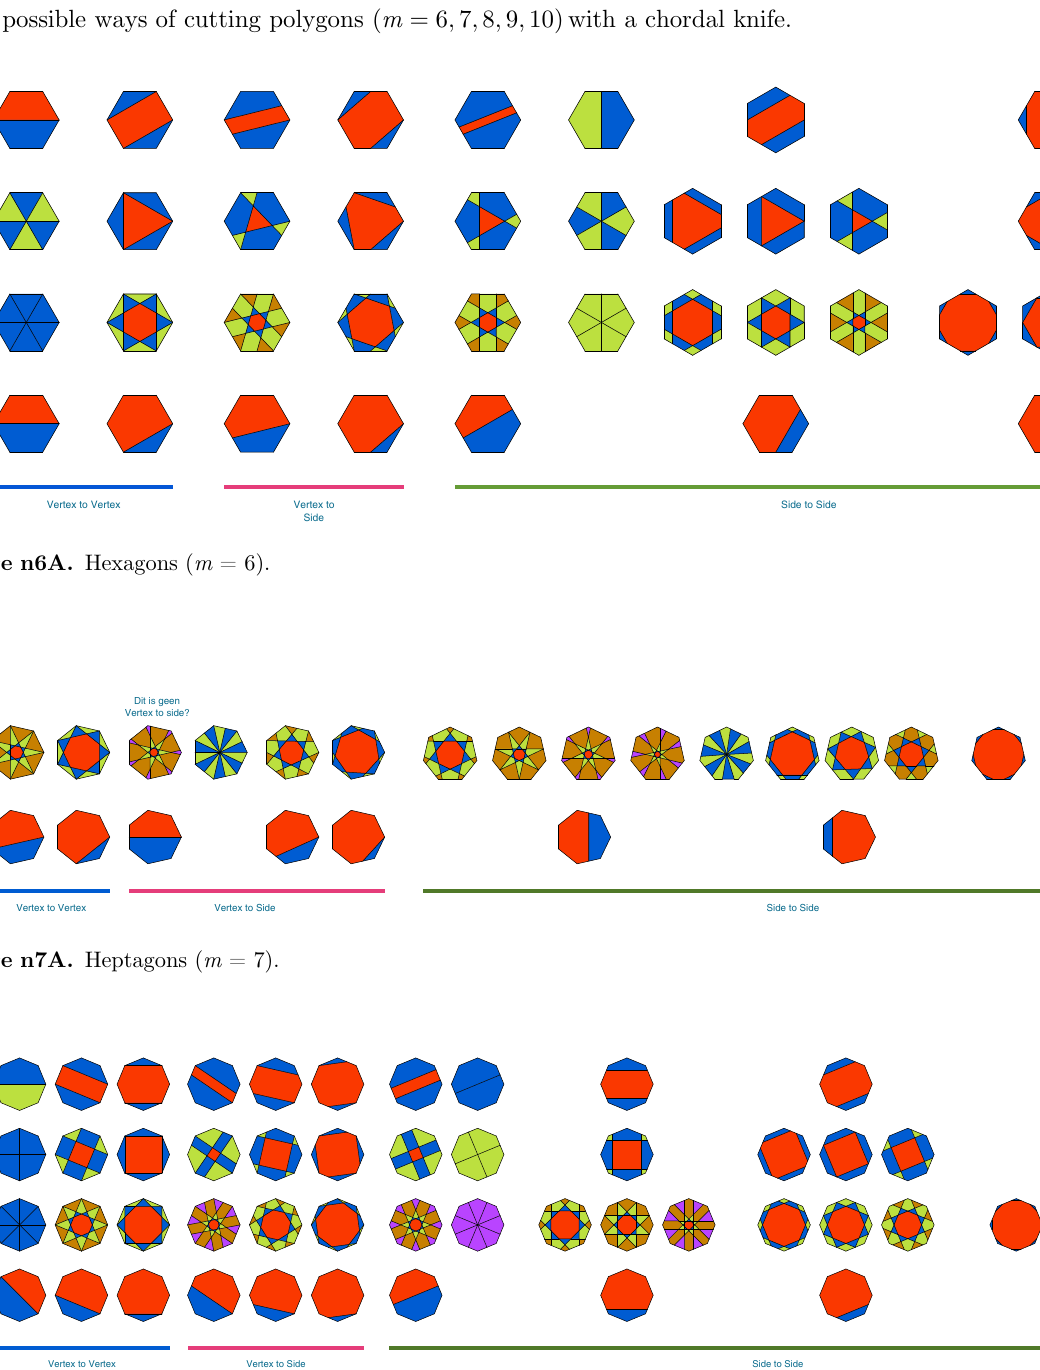
Figure n8A. Octagons ( m =